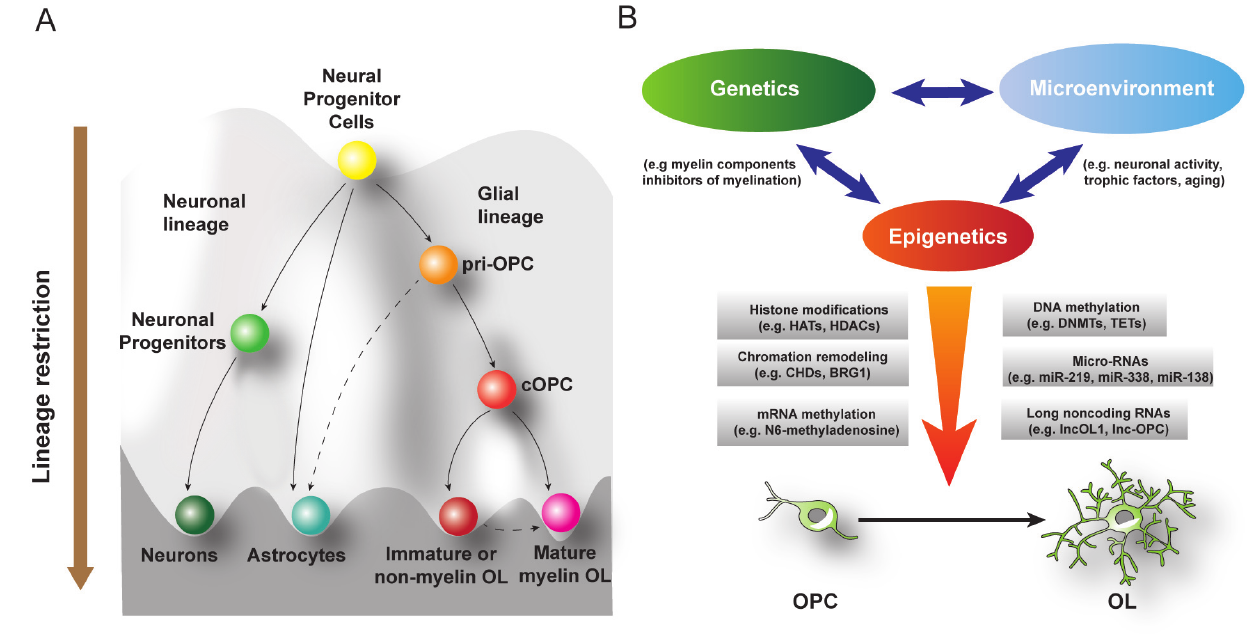
Figure 1. Differentiation of progenitor cells is a highly choreographed process. ( A ) A diagram depicts an epigenetic landscape of cellular fate decision-making during oligodendrocyte development from neural progenitor cells. Beginning with neural progenitors, cell differentiation occurs along multiple potential pathways with cells taking on neuronal, astrocyte, or oligodendrocyte lineages. This differentiation from a common progenitor population involves the fine tuning of gene expression and turning on and off of lineage-specific genes and their epigenetic regulators. ( B ) Many modulators of gene expression are through epigenetic mechanisms, which alter gene expression on the basis of local environmental factors. These mediators include covalent modifications to DNA or histones, RNA-mediated regulation of gene expression, or the enzymes responsible for mediating the effects of these modifications. BRG1, Brahma-related 1; CHD, chromodomain helicase DNA-binding; cOPC, committed oligodendrocyte progenitor cell; DNMT, DNA methyltransferase; HAT, histone acetyltransferase; HDAC, histone deacetylase; OL, oligodendrocyte; pri-OPC, primitive oligodendrocyte progenitor cell; TET, ten-eleven